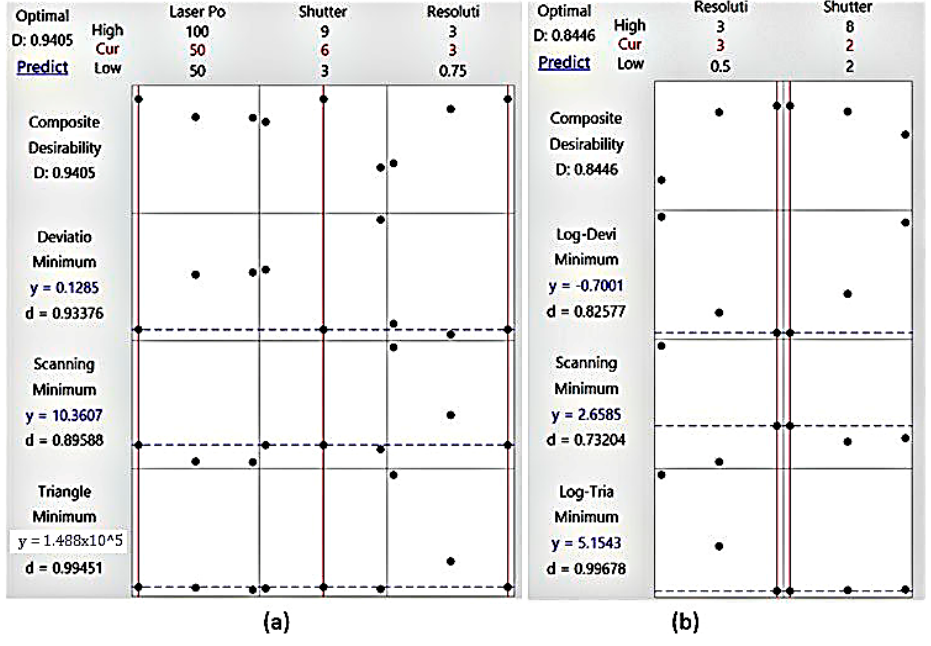
Figure 17. Optimization Plots—handheld: ( a ) laser scanner; ( b ) white light scanner.